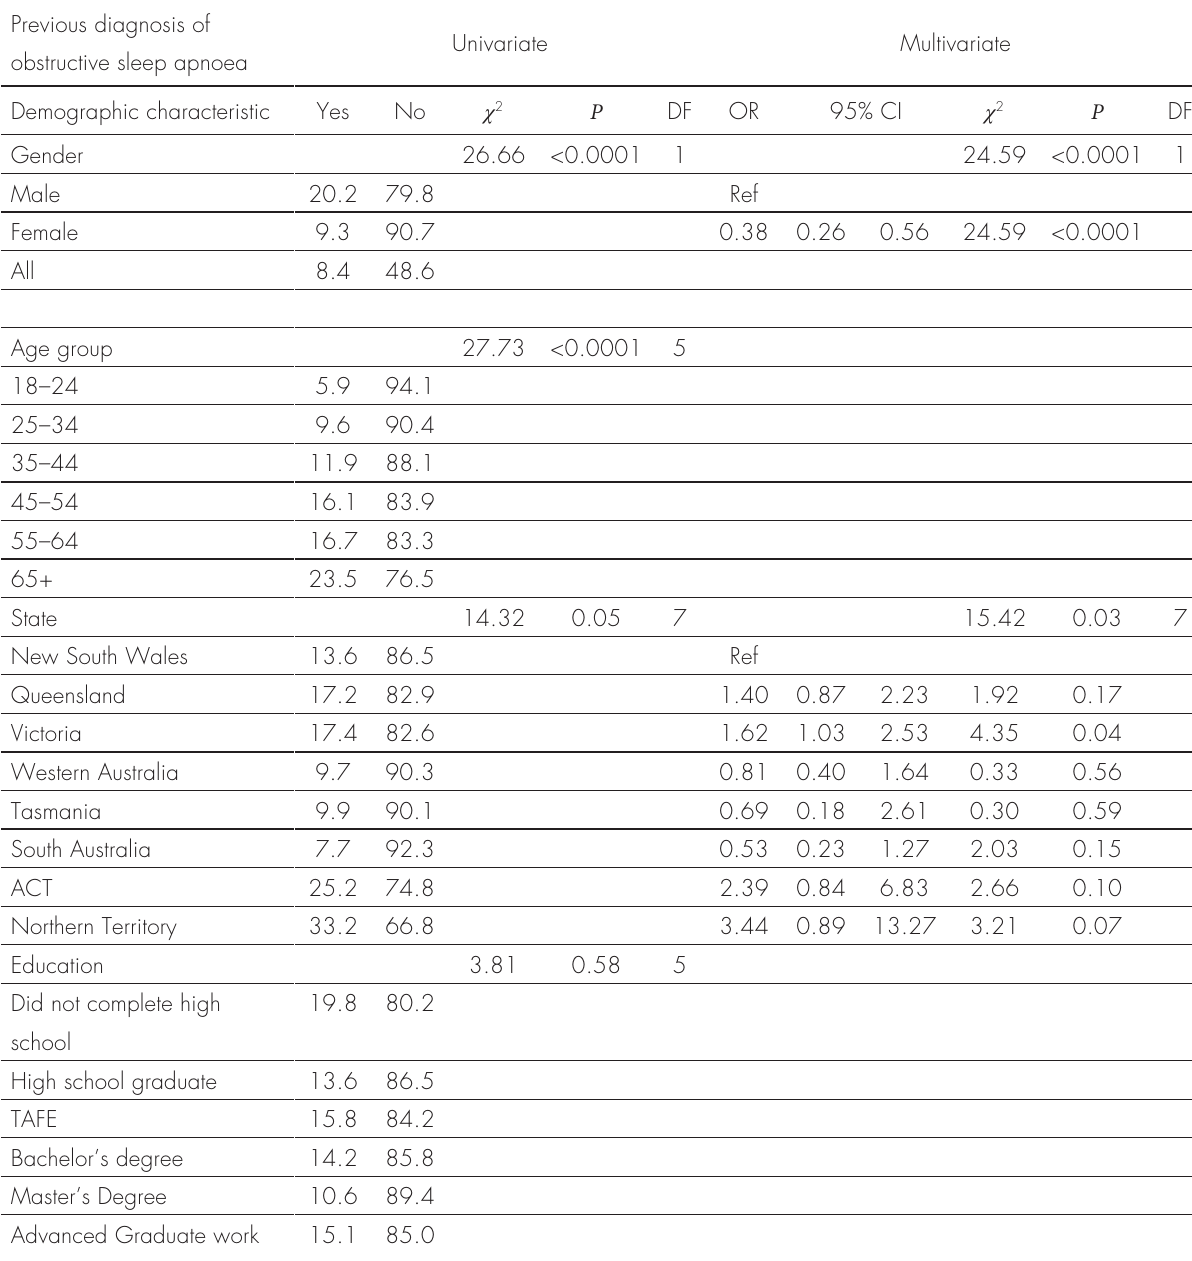
Table IV. Demographic characteristics (gender, age group, education, employment status, annual income) and their associations with previous diagnosis of obstructive sleep apnoea. Previous diagnosis of obstructive sleep apnoea